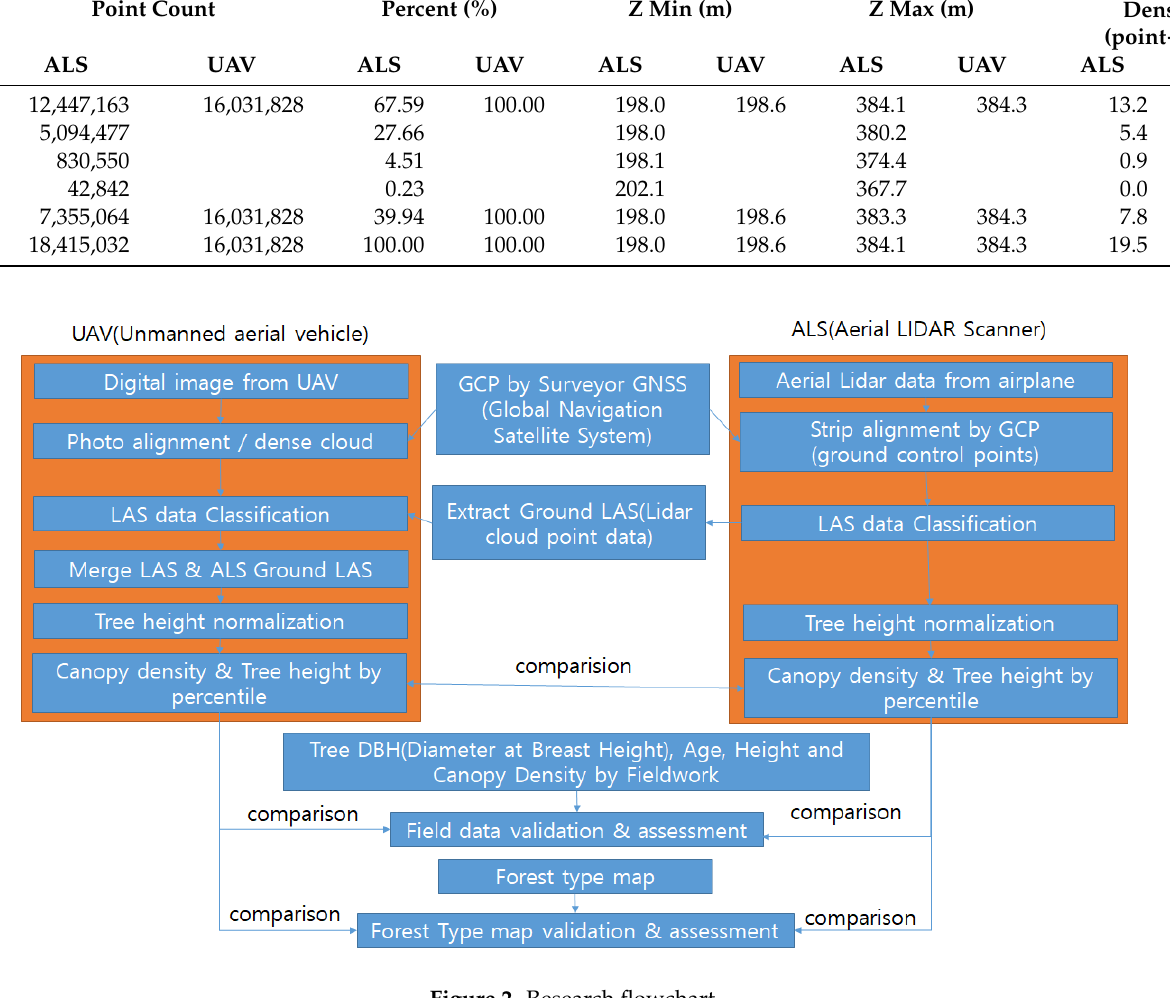
Figure 2. Research flowchart.